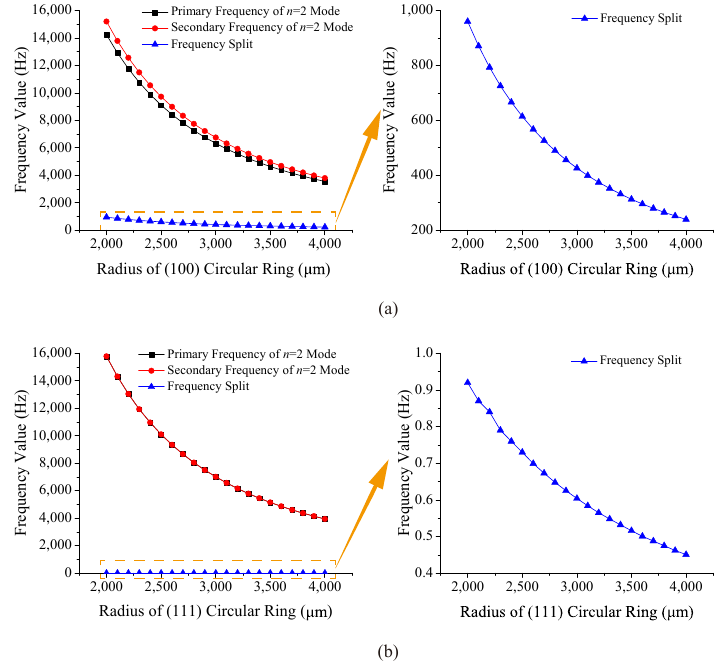
Figure 4. Resonant frequencies and frequency splits of rings with different radii: ( a ) (100) ring, ( b ) (111) ring.